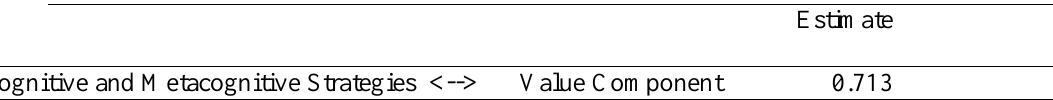
Table.3(b). Correlations: (Group number 1 - MSLQ1)